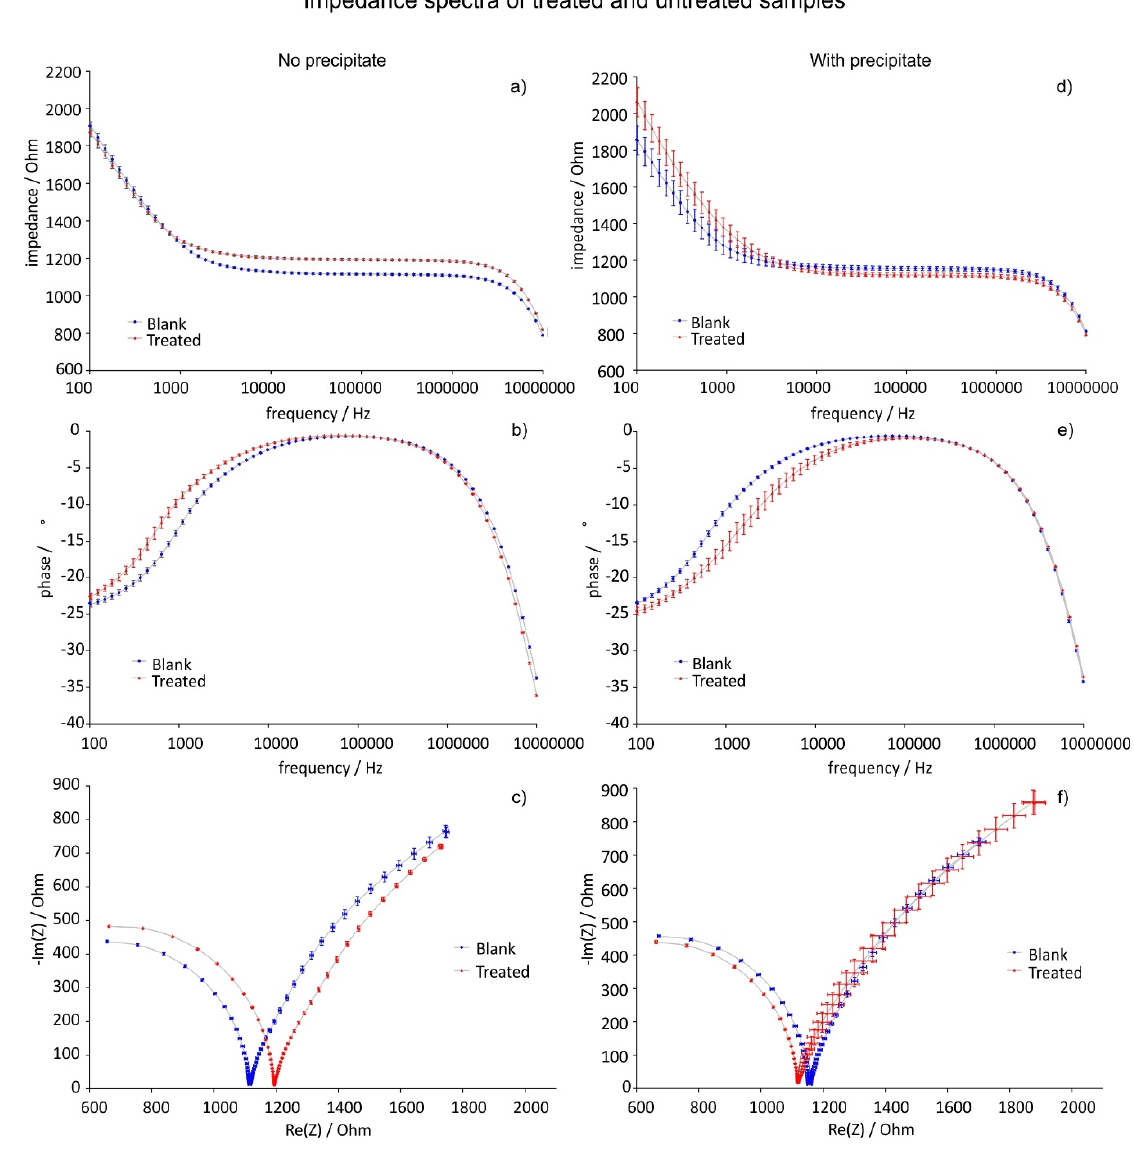
Figure 11. Examples of the two effects accompanying the DOLLOP formation. Depending on the presence of precipitate, the impedance either increases or decreases. These effects are shown as impedance ( a , d ), phase ( b , e ) and Nyquist plots ( c , f ): Case a ( a , b , c ) was encountered without precipitate; case b ( d , e , f ) was found when a small amount of precipitate was found in the reference beaker, but none in the treated beaker after treatment. The error bars represent the measurement error. Table 3. Parameter fit for Figure 11, case a . The errors represent the quality of the fit for each element. Blue and red font colours are used to highlight an increasing or decreasing trend, respectively. Absolute Relative Parameter Untreated Treated Difference